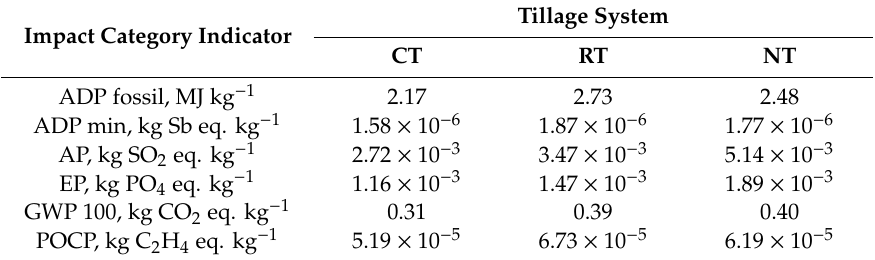
Table 6. Values of impact category indicators of the winter wheat production under conventional tillage (CT), reduced tillage (RT), and no-tillage (NT) systems per functional unit of 1 kg of